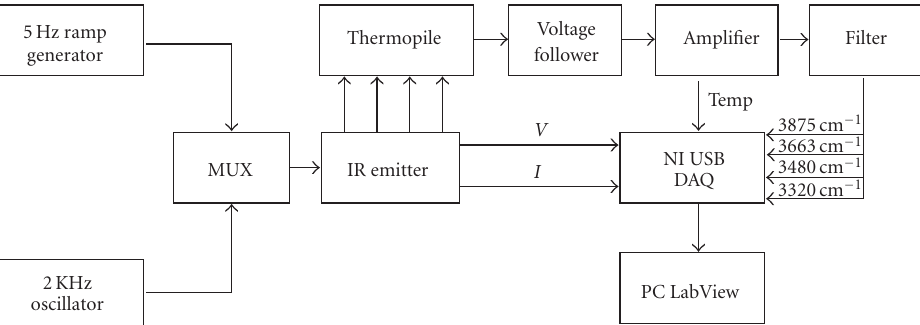
Figure 10: Block diagram of the sensor electronics.